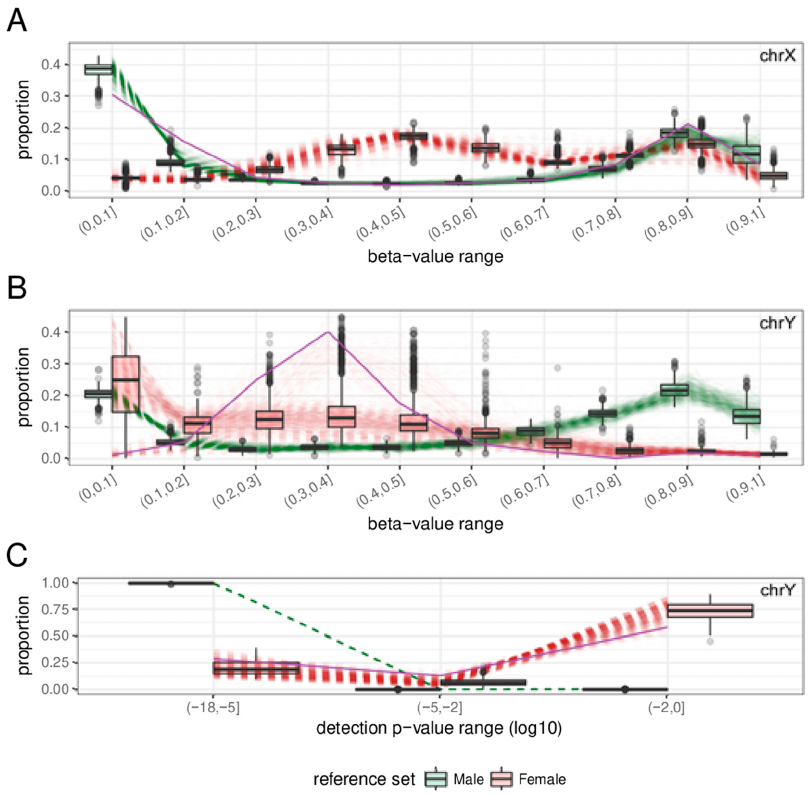
Figure 5. Beta-value/detection p -value distribution of the Turner syndrome sample. Sample GSM1572595, shown in purple, exhibits a male-like pattern for chrX ( A ) and a female-like pattern for chrY ( B , C ). Dashed green and red blurred lines show the profiles of reference samples.